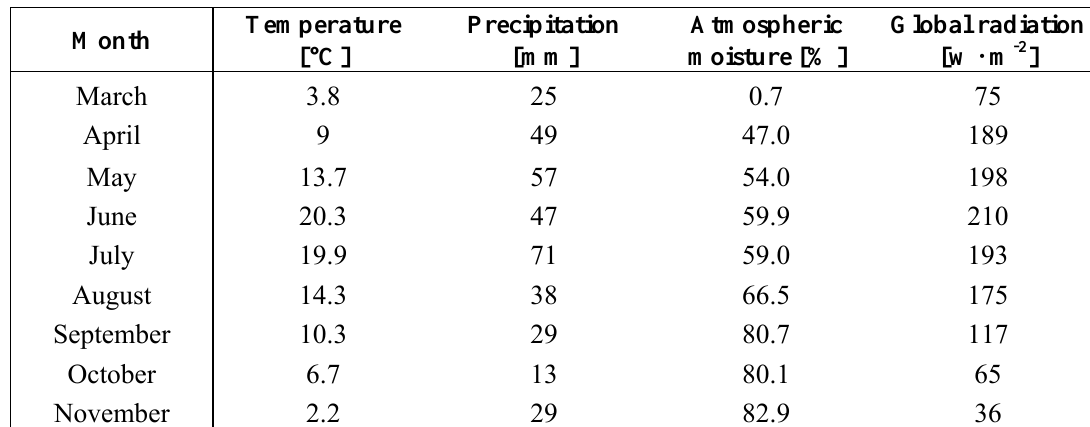
Table 6. Climatic